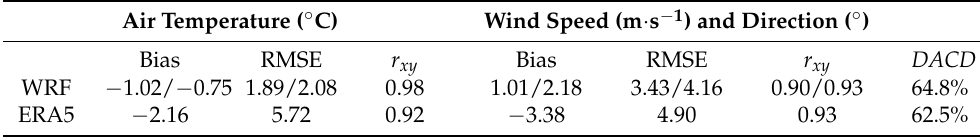
Table 3. Validation statistics for air temperature, wind speed and direction from the WRF simulations and the ERA5 reanalysis for the winter period on Davies Dome. For WRF, an interval including all boundary layer (BL) schemes is presented. Wind direction accuracy is shown as the directional accuracy of circular distance